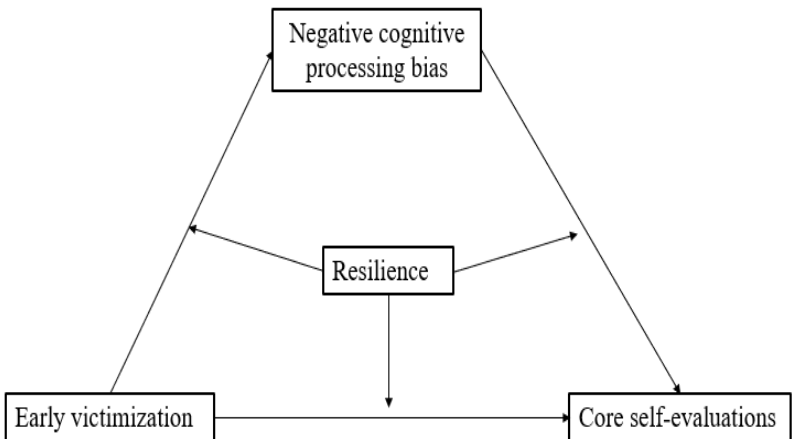
Figure 1. The conceptual model.